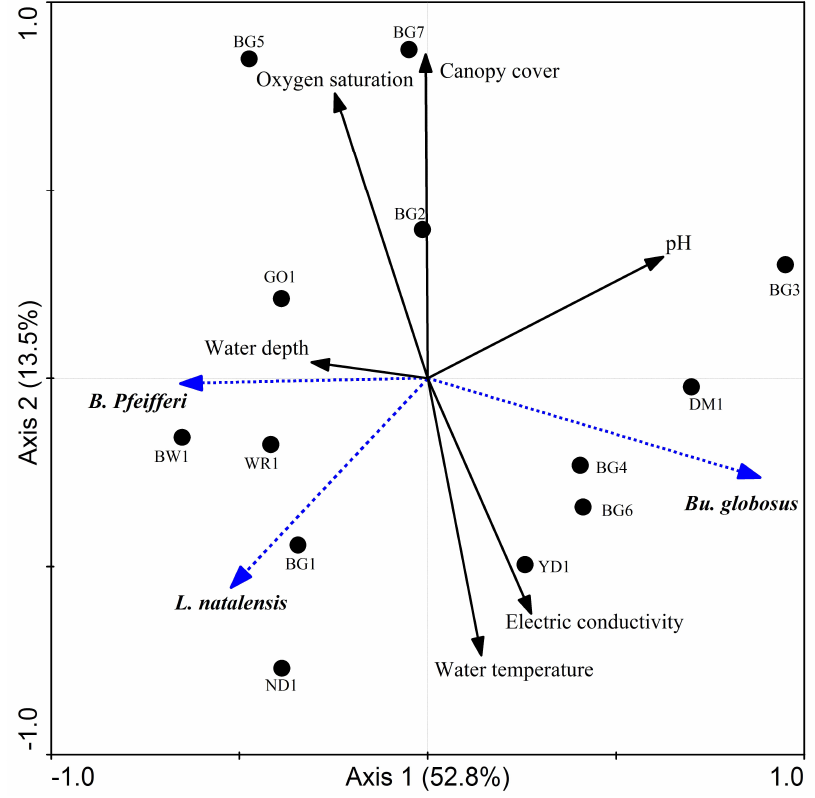
Figure 4. Redundancy analysis (RDA) of snail and environmental